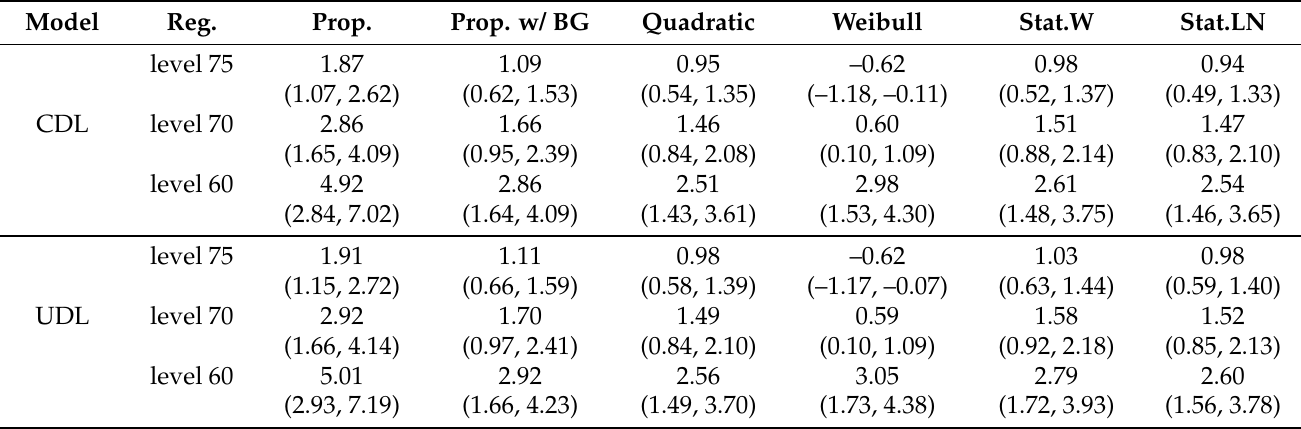
Table 1. Posterior means and 95% confidence intervals of total mortality reduction per 1000 deaths (1998–2000): common rollback.